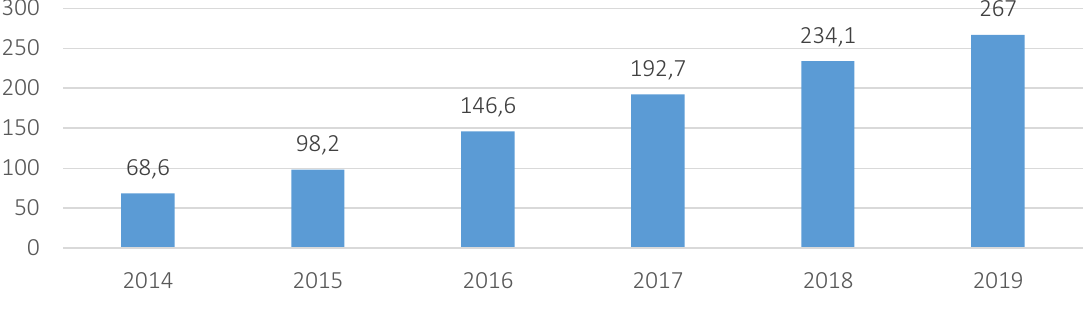
Figure 1. Own revenues of local budgets fund, UAH billion